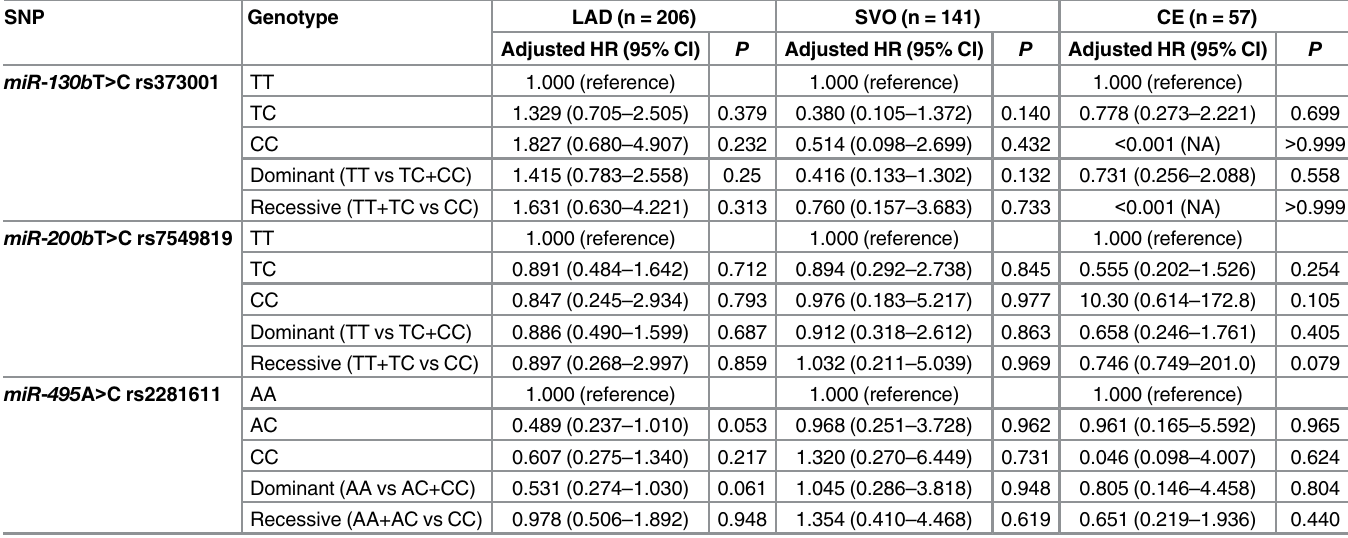
Data are derived by multivariate Cox regression adjusted for age, sex, hypertension, diabetes mellitus, hyperlipidemia, and current smoking. CI = con fi dence interval, HR = hazard ratio, LAD = large-artery disease, SNP = single nucleotide polymorphism, SVO = small-vessel occlusion, CE = cardioembolism, NA = not